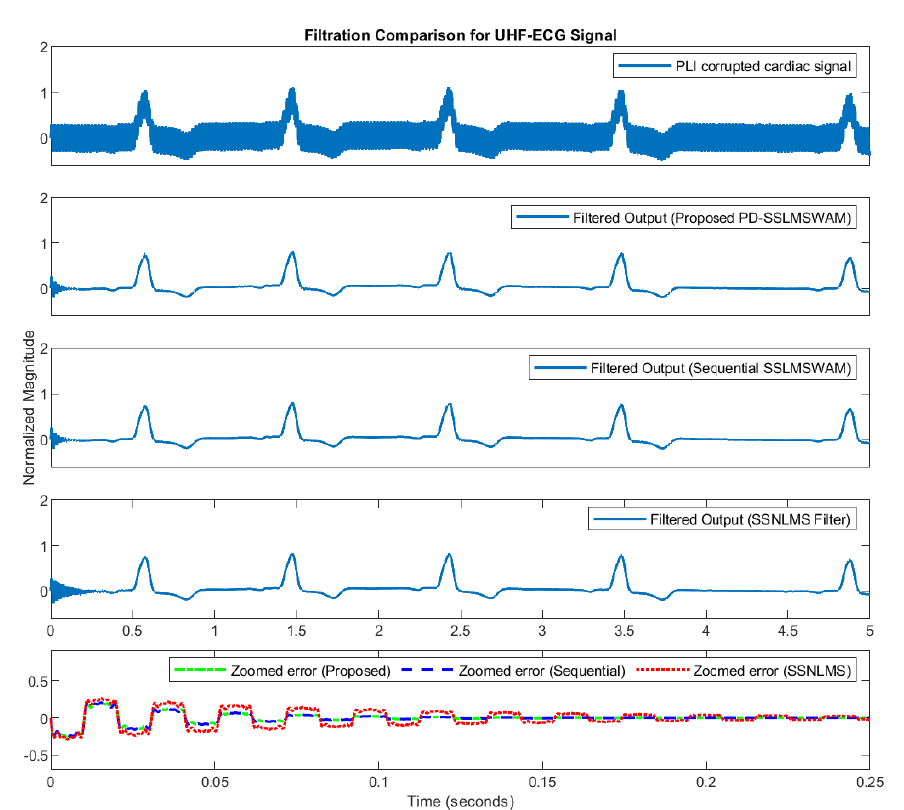
Figure 8. Filtration comparison among proposed PD–SSLMSWAM, sequentially operated SSLM- SWAM, and SSLNLMS adaptive filters for the UHF–ECG cardiac signal.